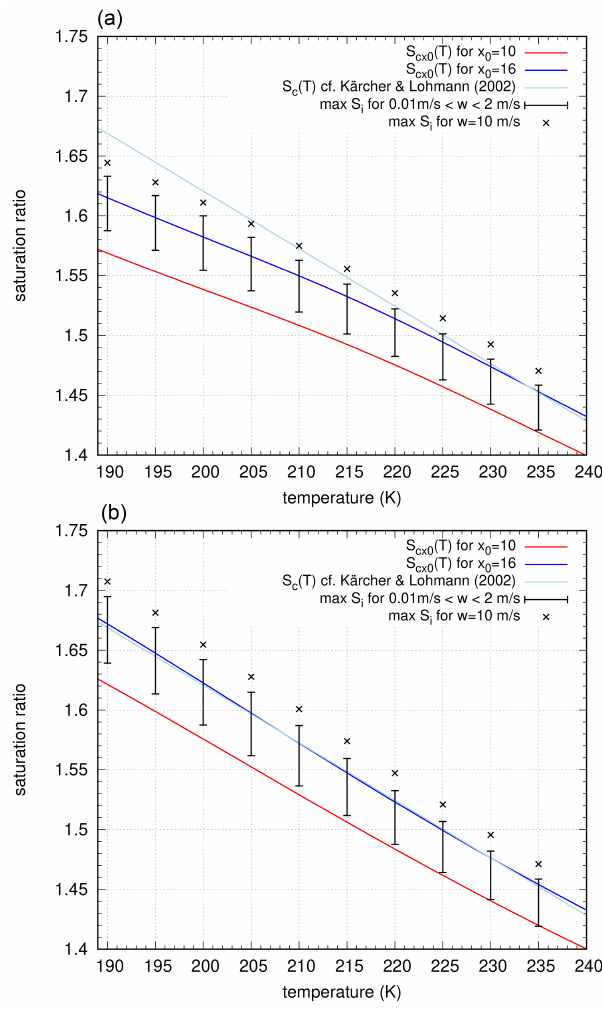
Figure 13. Comparison of nucleation thresholds (red curve: x 0 = 10, blue curve x 0 = 16) and the classical Koop line (light blue curve). The black vertical bars indicate the range of peak super- saturation ratios within the nucleation events, computed using ver- tical velocities ranging from 0.01 to 2ms − 1 . The black cross cor- responds to the peak supersaturation ratio for the vertical velocity of 10ms − 1 . (a) Curves based on the water activity using the sat- uration vapour pressure formulation by Murphy and Koop (2005) and (b) the same for the saturation vapour pressure formulation by Nachbar et al.